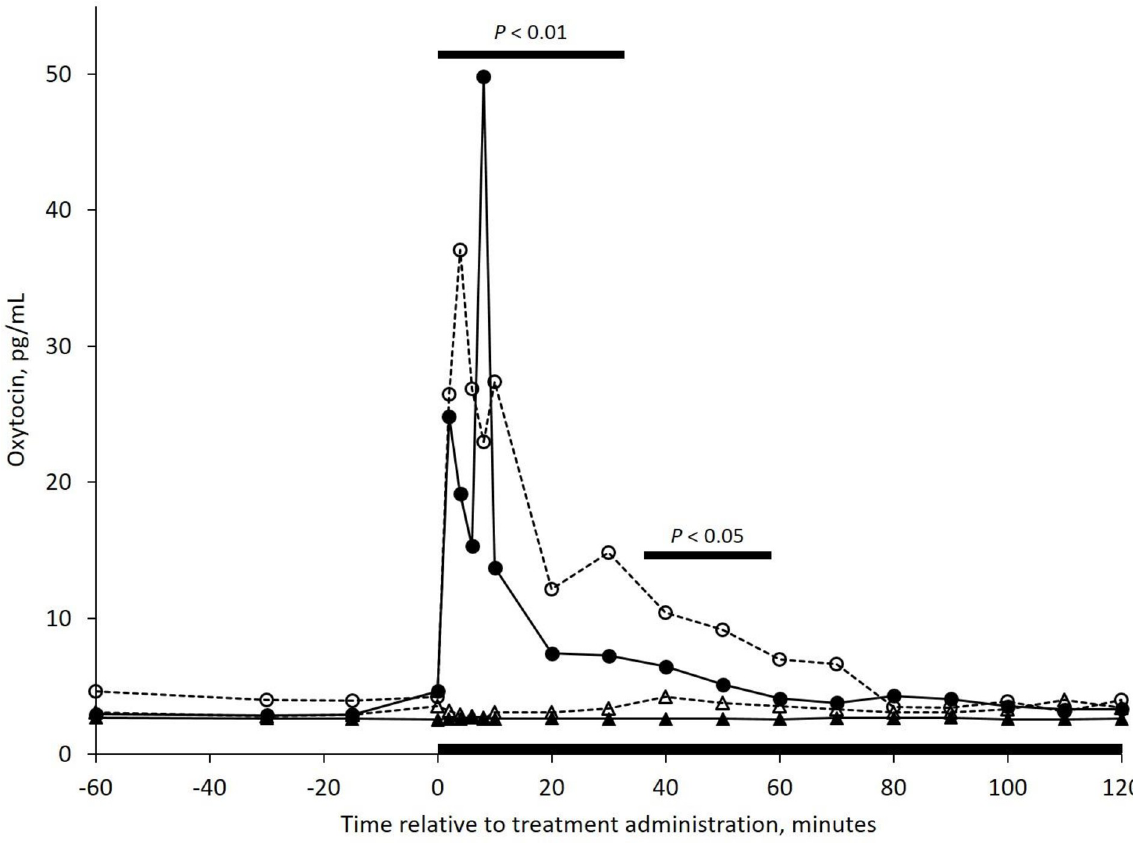
Fig 3. Back transformed mean plasma oxytocin concentration in Bos taurus cows assigned to one of four treatments. Treatments included 1) Non-lactating, saline (NL-S, – – Δ – –; n = 5), 2) Non-lactating, oxytocin (NL-OXT, – – � – –; n = 5); 3) Lactating, saline (L-S, ── ▲ ── ; n = 5); and 4) Lactating, oxytocin (L-OXT, ── ● ── ; n = 3). Intra-nasal treatments (S or OXT) were administered at 0 minutes followed by two hours of head restraint, as indicated by the black bar. Oxytocin was administered intra-nasally at a rate of 0.60 IU/kg bodyweight. A treatment by time interaction was detected from 60 to 90 minutes ( P < 0.01) and from 90 to 110 minutes ( P < 0.05).